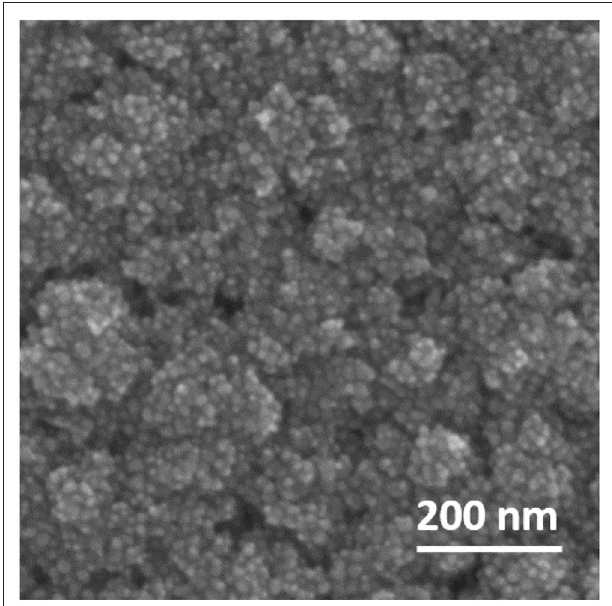
FIGURE 1 | Scanning electron microscopy (SEM) image: plan view of the dust structure corresponding to sample P2, showing the two phases, organosilicon dust and silver nanoparticles organized in a “raspberry-like”